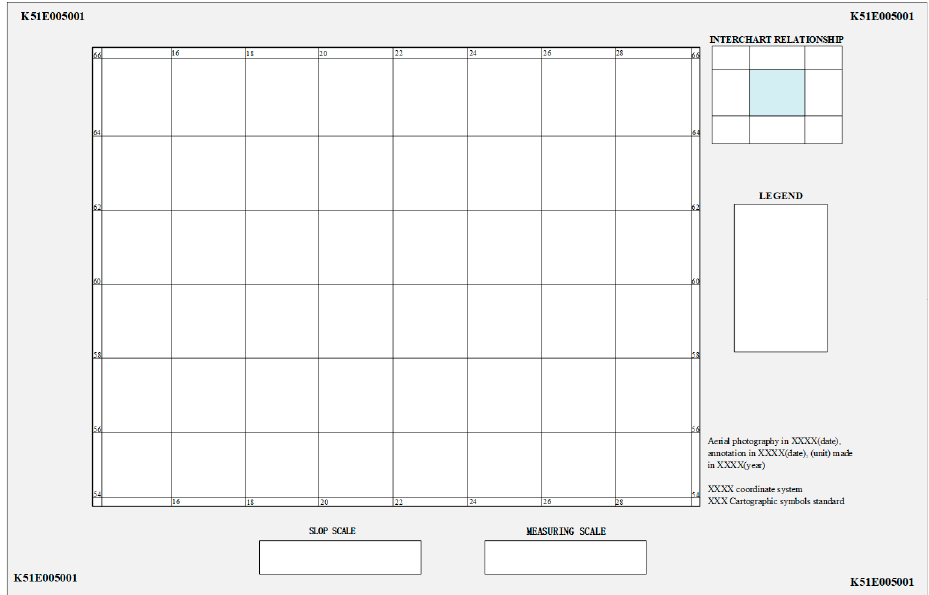
Figure 1. Style of topographic